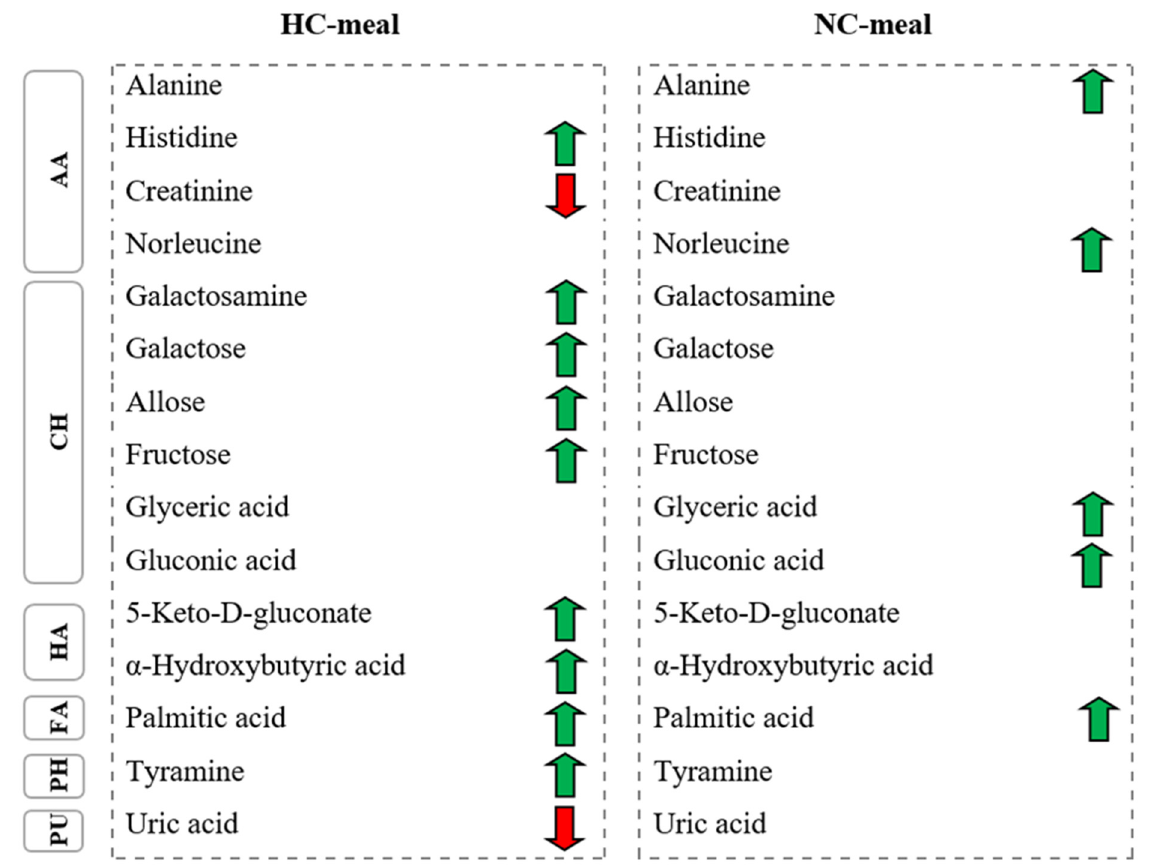
Figure 3. The summary of metabolic alternations observed after NC- and HC-meal intake. AA—Amino acids, CH—Carbohydrates, HA—Hydroxy acids, DI—Dicarboxylic acids, FA—Fatty acids, PH—Phenethylamines, PU—Purines, KA—Keto acids. Red arrows indicate a decrease, whereas green arrows indicate an increase in the metabolite level in HR genotype compared to the LR genotype. Transverse stripes show metabolites common between two meals.